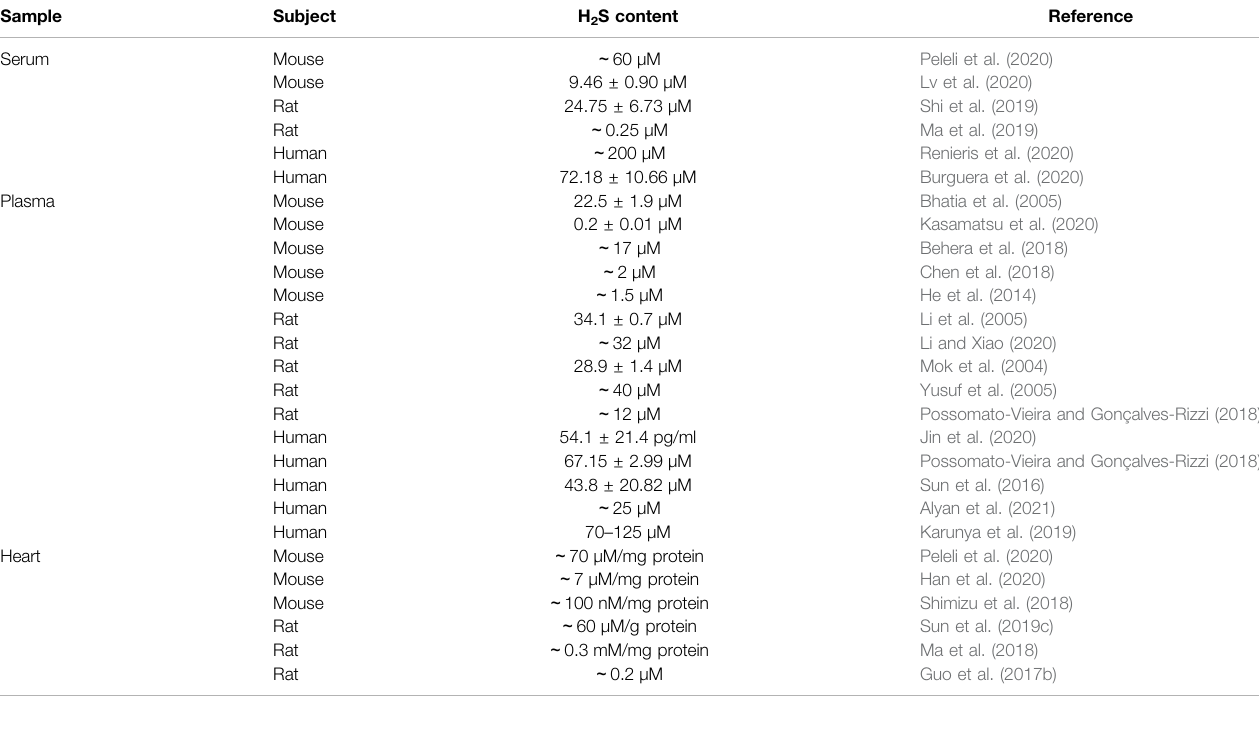
TABLE 3 | H 2 S concentrations in blood or cardiac tissues under physiological conditions. Sample